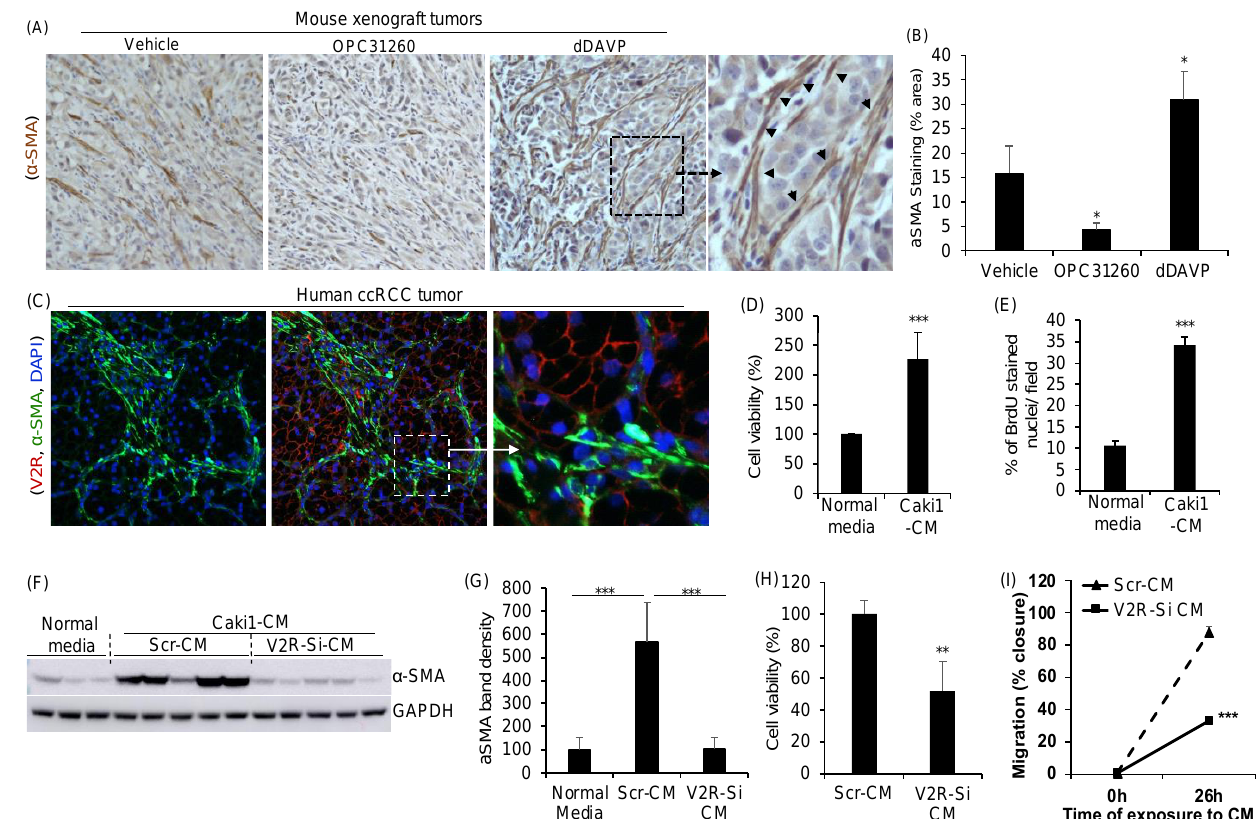
Figure 1. V2R in ccRCC tumor cells is important for paracrine regulation of fibroblasts: ( A ) Nu/Nu mice were inoculated subcutaneously with Caki1 cells. Ten days later, mice were treated with vehicle OPC31260 (30 mg/Kg) or dDAVP (1 µ g/Kg) daily for 28 days. Immunostaining of tumor tissue sections for α SMA (brown). ( B ) Quantitation of immunostaining. ( n = 4 tumors per group). ( C ) In human ccRCC tumor tissue, immunostaining for α SMA (green), V2R (red), and DAPI (blue). ( D ) Cell viability measured by MTT assay on NRK-49F renal fibroblasts exposed to serum-free conditioned cell culture media (CM) from Caki1 cells for 48 h. ( n = 6), and ( E ) Cell proliferation of NRK-49F cells treated with Caki1-CM for 48 h measured as % BrdU positive nuclei/total DAPI stained nuclei/field/experiment ( n = 5). Cells were exposed to BrdU (3 µ g/mL) for 3 h before the end of the study. ( F ) Immunoblot of NRK-49F cells exposed to normal control media (media not previously exposed to any cells) or CM from Caki1 cells transfected with V2R-SiRNA (V2R-SiRNA-CM) or Scr (Scr-CM) for 48 h. and ( G ) quantitation of band density relative to GAPDH. ( H ) MTT assay on NRK-49F cells exposed to Scr-CM or V2R-SiRNA-CM for 48 h ( n = 6) and ( I ) % wound closure in the scratch assay of NRK-49F cells exposed to Scr-CM or V2R-SiRNA-CM ( n = 5). * p < 0.05**, p < 0.01, *** p < 0.001 by t -test.